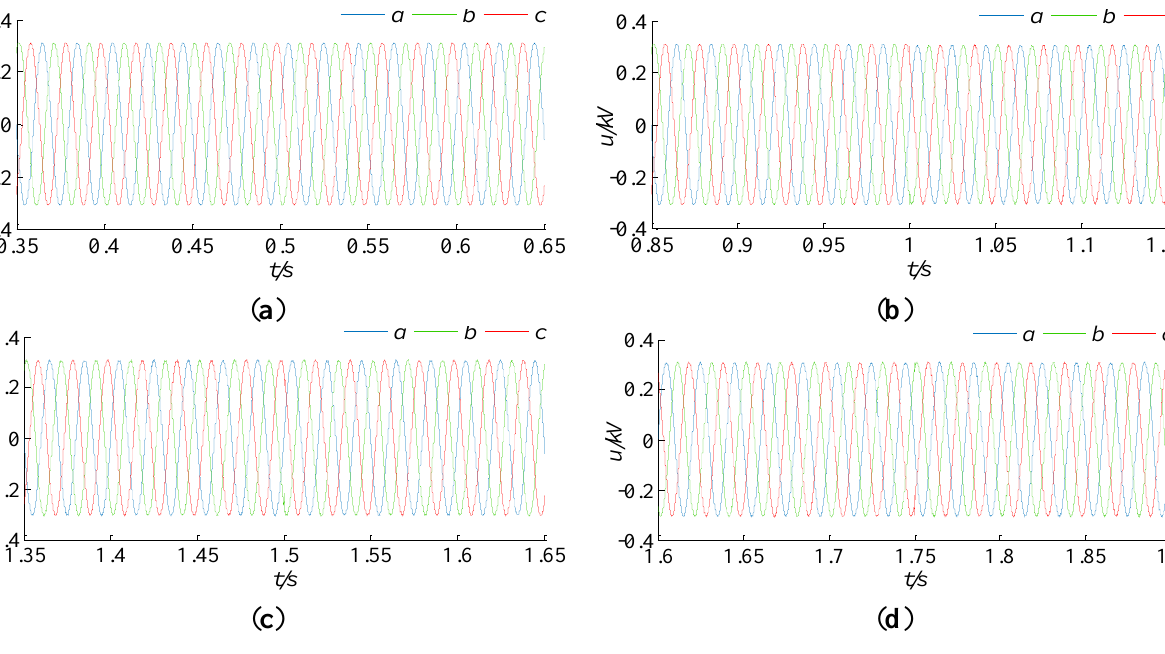
Figure 7. ( a ) Voltage waveform of the MSC between 0.35 s and 0.65 s; ( b )